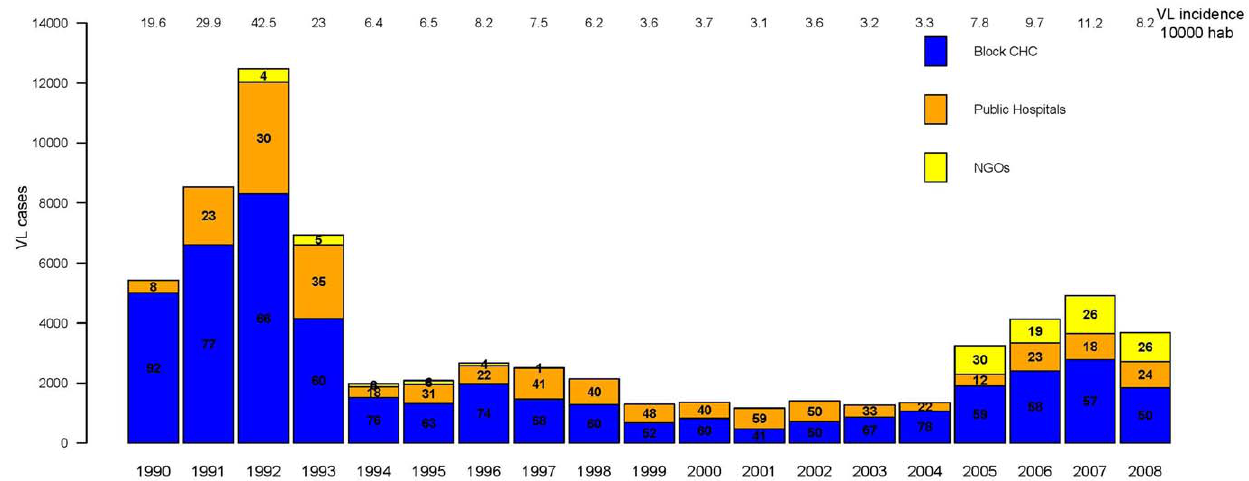
Figure 1. The total numbers of Visceral Leishmaniasis (VL) cases reported in Muzaffapur district per year from 1990 to 2008. The proportion of cases reported to the different health care facilities: Community Health Centre (CHC), Public Hospitals or Non-Governmental Organisation (NGO) is represented as percentage of the total cases per year inside boxes of different colours. The annual VL incidence rate (per 10,000) in Muzaffarpur district is noted at top of the figure.